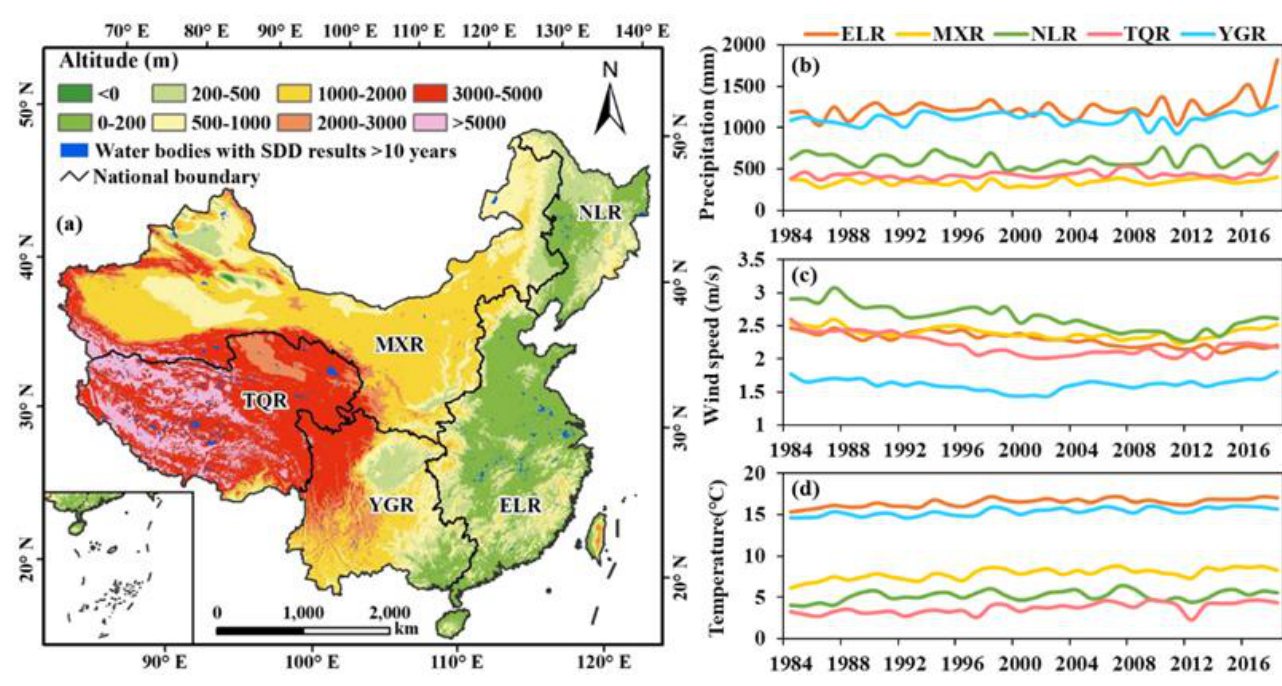
Figure 1. Examined lakes distributed in five lake regions across China ( a ) and annual mean meteor- ological data in five lake regions during 1984 – 2018, i.e., precipitation ( b ), wind speed ( c ), and tem- perature ( d ). Note that the data on water bodies were sourced from Tao et al. (2022), and the mete- orological data derived from the National Meteorological Information Center.